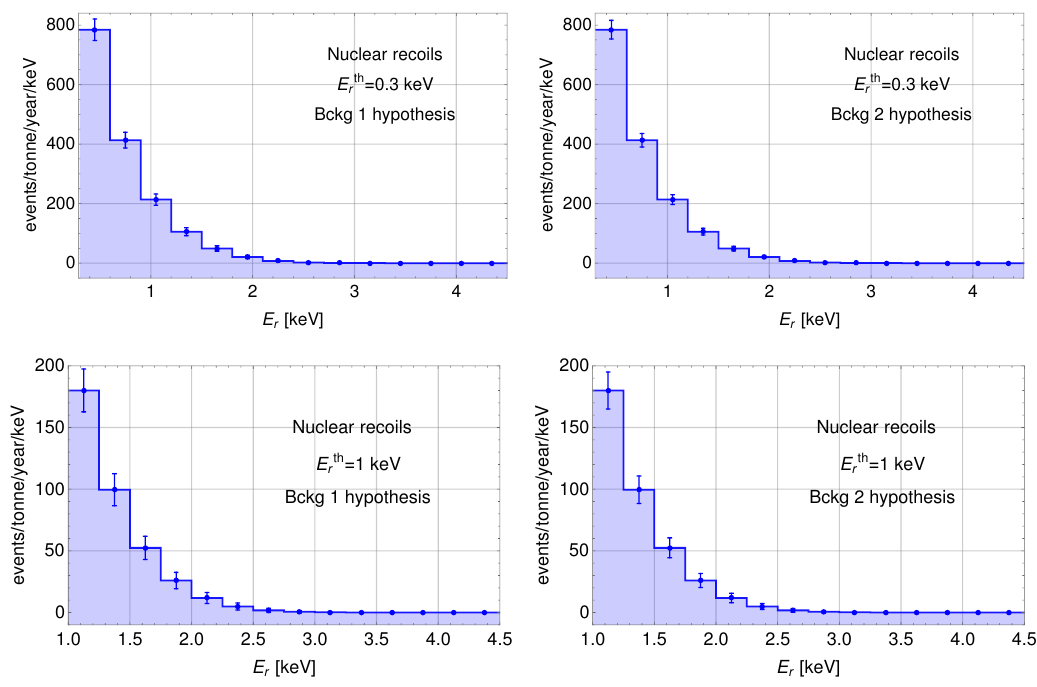
Figure 1 . Top graphs : CE ν NS toy experiment signals for a 0 . 3 keV threshold with a background amounting to 68% (left) and 25% (right) of the signal rate, Bckg 1 and Bckg 2 hypotheses re- spectively. The result assumes 100% detector efficiency and one tonne-year exposure. Bottom graphs : same as the top graphs but for 1 keV threshold instead. For the CE ν NS analysis, these are the “experimental” signals we have assumed. As can be seen, results are rather sensitive to threshold